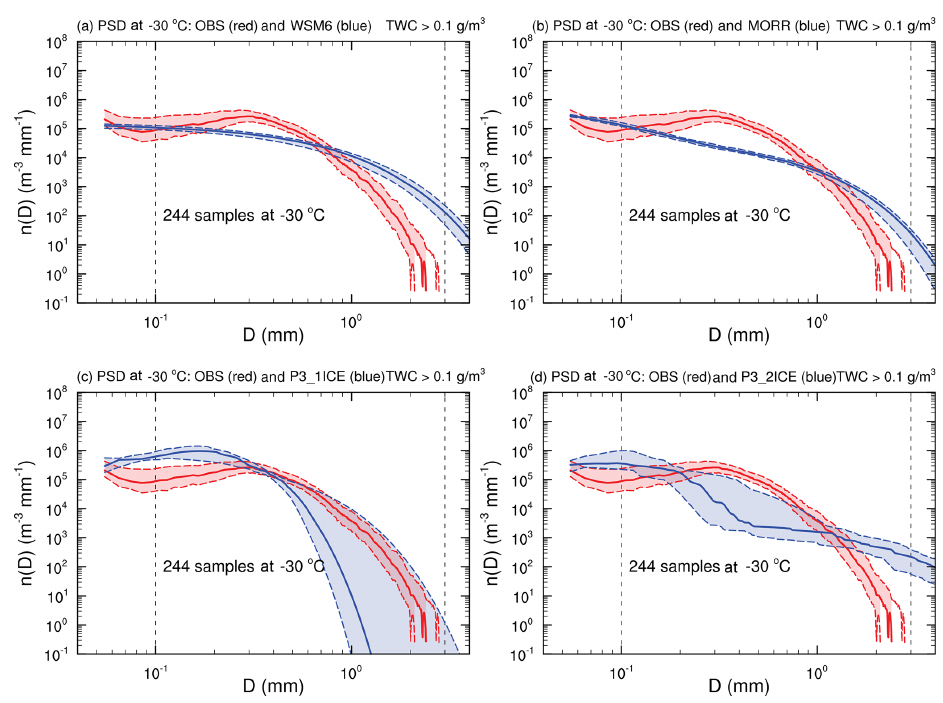
Figure 9. Observed (red) and simulated (blue, a : WSM6, b : MORR, c : P3-1ICE, d : P3-2ICE) ice particle size distributions at the level of − 30 ◦ C. The red and blue dashed lines indicate the 25th and 75th percentiles, and the red and blue solid lines represent the